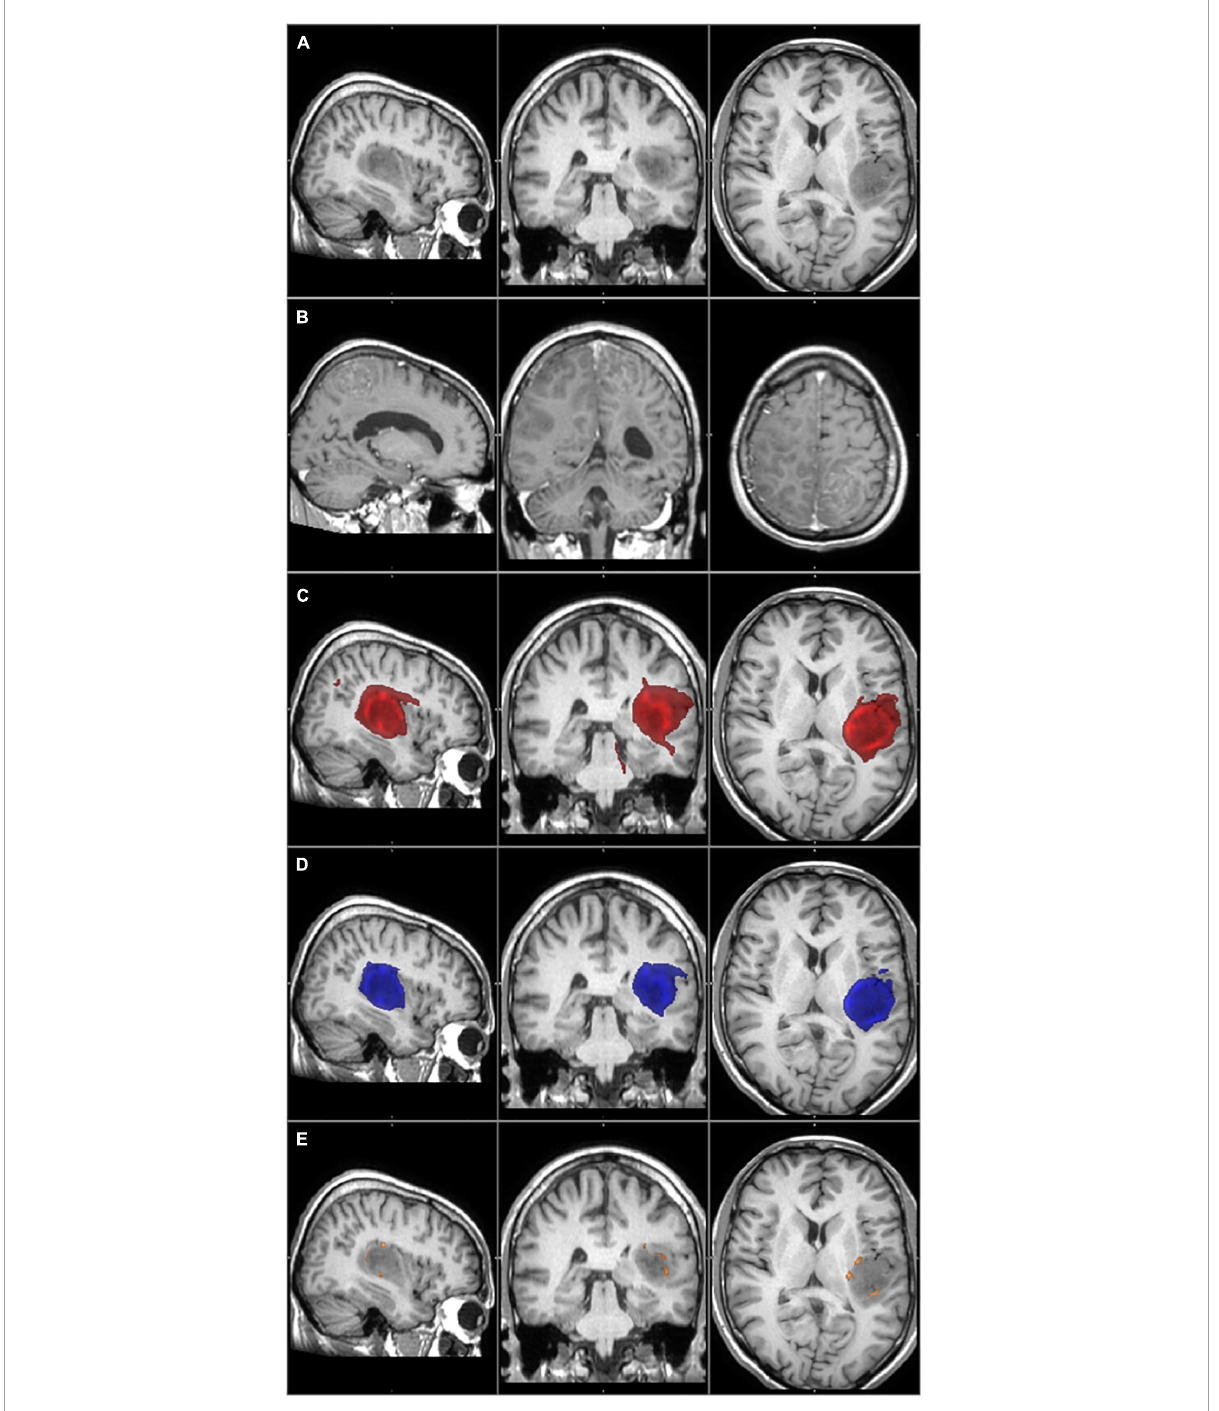
FIGURE3 The primary tumor, the recurrence tumor, and the overlap between the different TCs and the tumor recurrence mask of the representative case of Patient 1 are displayed in this figure. All images are transformed to the MNI152 1 mm space. (A) The preoperative contrast enhanced T1 image. The tumor is located in the left temporo-parietal region and does not enhance the contrast agent, but histology verified the glioblastoma. (B) The size and the location of the tumor recurrence. (C) The 1% TC (red) is overlapped on the tumor recurrence mask (green). (D) The 5% TC (blue) is overlapped on the tumor recurrence mask (green). (E) The 40% TC (red-yellow) is overlapped on the tumor recurrence mask (green). (C–E) Are on the preoperative T1 images. The main part of the recurrence is far away from the original tumor location, which leads to very low sensitivity even at the 1% threshold